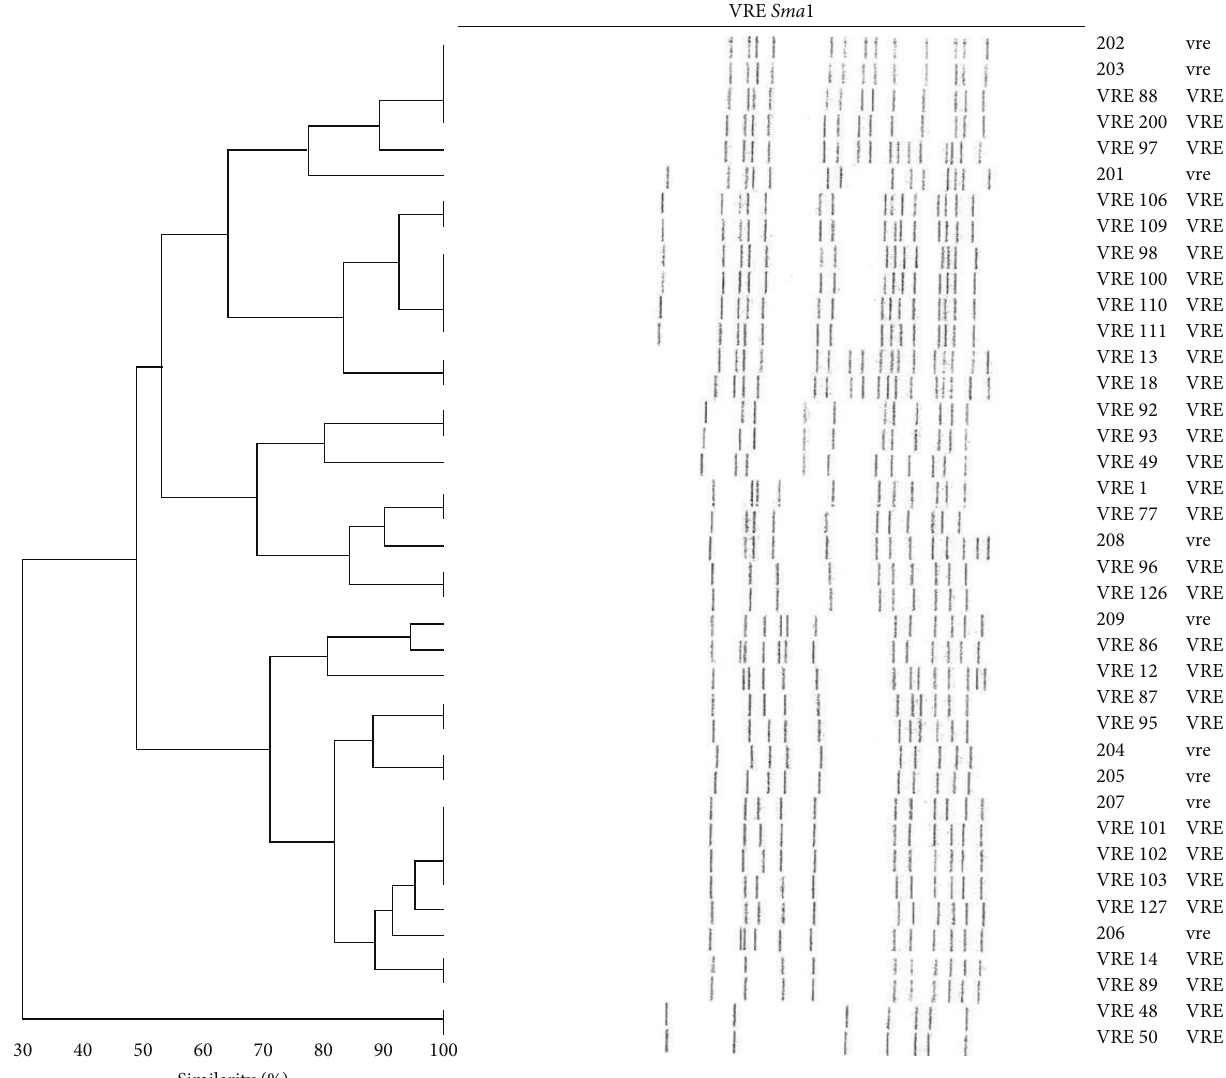
𝑁 = number of isolates distribution; PFGE = pulsed-field gel electrophoresis pattern signifying the same clone; UGT = urogenital tract; SSTI = skin and soft tissue infections; GIT ∗ = gastrointestinal tract, and this sole isolate was from the peritoneal fluid of a patient who had peritonitis. All seven vancomycin- resistant E. faecalis had an identical PFGE pattern indicating they belong to the same clone.